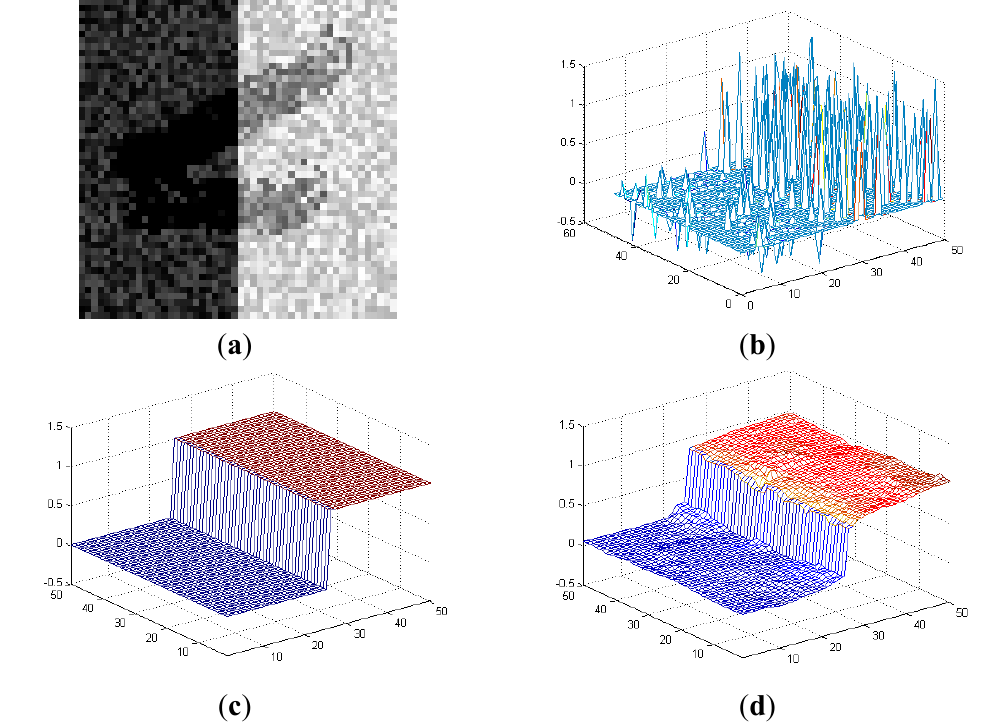
Figure 5. ( a ) Visual image containing noises and shadow; ( b ) Sparse range points; ( c ) Ground truth curb data; ( d ) Recovered depth image shown in 3D.